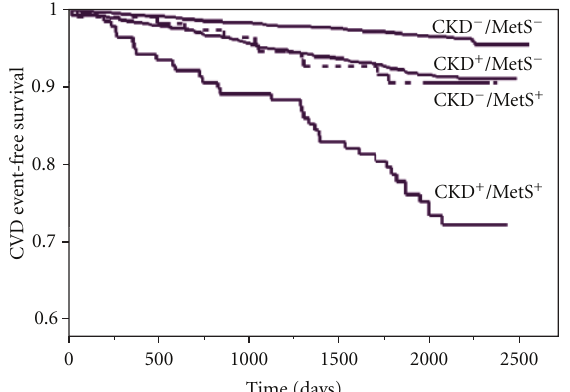
Figure 1: Kaplan-Meier plots showing cumulative CVD event- free survival in participants in four groups divided by presence or absence of CKD and presence or absence of MetS (log-rank test for trend X 2 = 114; P < 0 . 001); CKD: chronic kidney disease; MetS: metabolic syndrome; CVD: cardiovascular disease.